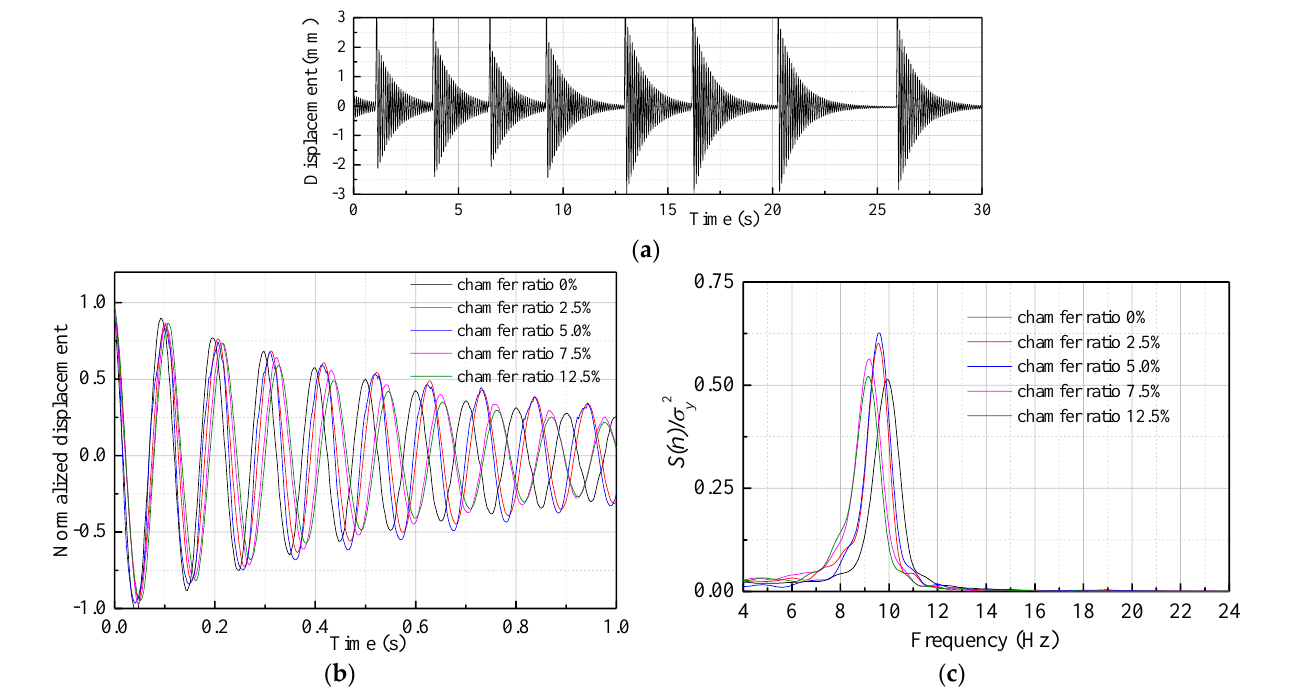
Figure 5. Free vibration result of the aeroelastic models with chamfered corners: ( a ) free vibration displacement of Case 2; ( b ) normalized free vibration displacement; ( c ) normalized PSD of free vibration displacement.